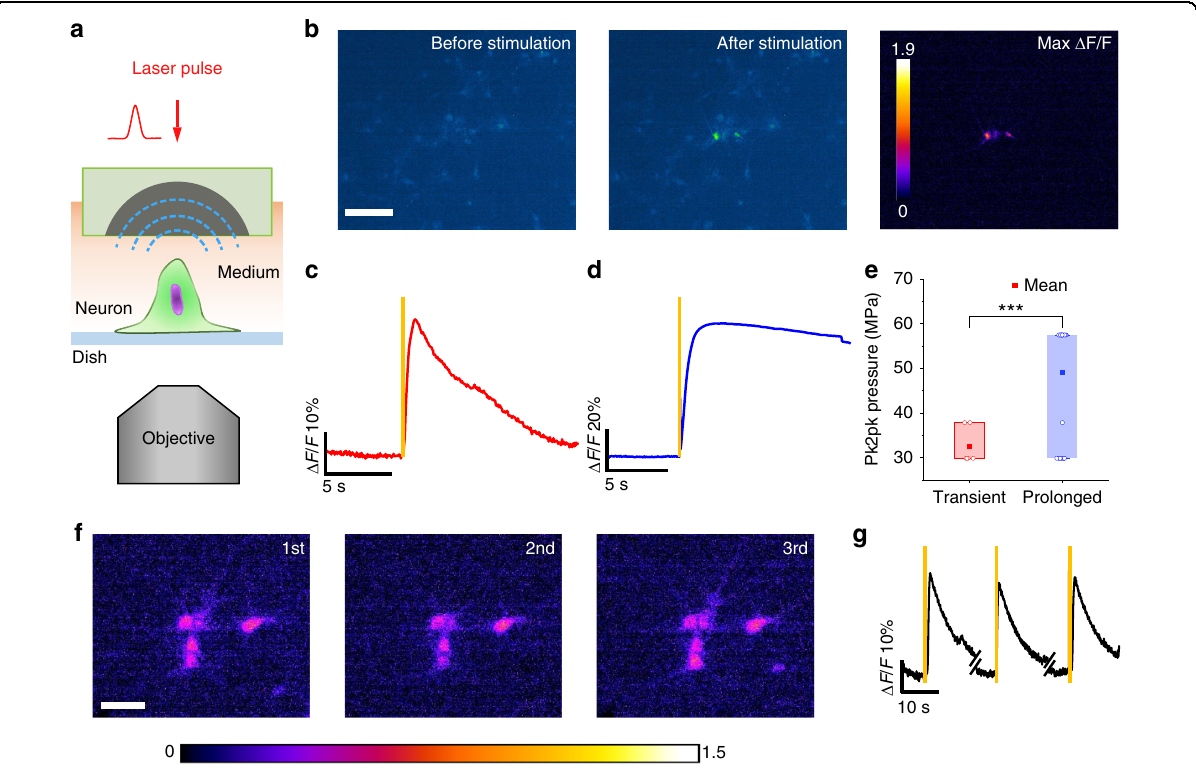
Fig. 3 Cultured neurons are stimulated by OFUS delivered by SOAP in vitro. a The schematic of OFUS stimulation setup. b Representative calcium images of neurons before and after OFUS stimulation. The right panel shows the maximum Δ F/F. Scale bar: 50 μ m. c The average calcium trace of transient stimulation. d The average calcium trace of prolonged OFUS stimulation. Average traces in solid and SEM in shades. Yellow vertical lines: laser on. e Statistics of the threshold pressure of transient and prolonged stimulation. *** p < 0.001. f Maximum Δ F/F image of repeated stimulation for the safety demonstration. Scale bar: 50 μ m. g Calcium traces corresponding to the repeated stimulation in E were taken from the same neuron. Yellow vertical lines: laser